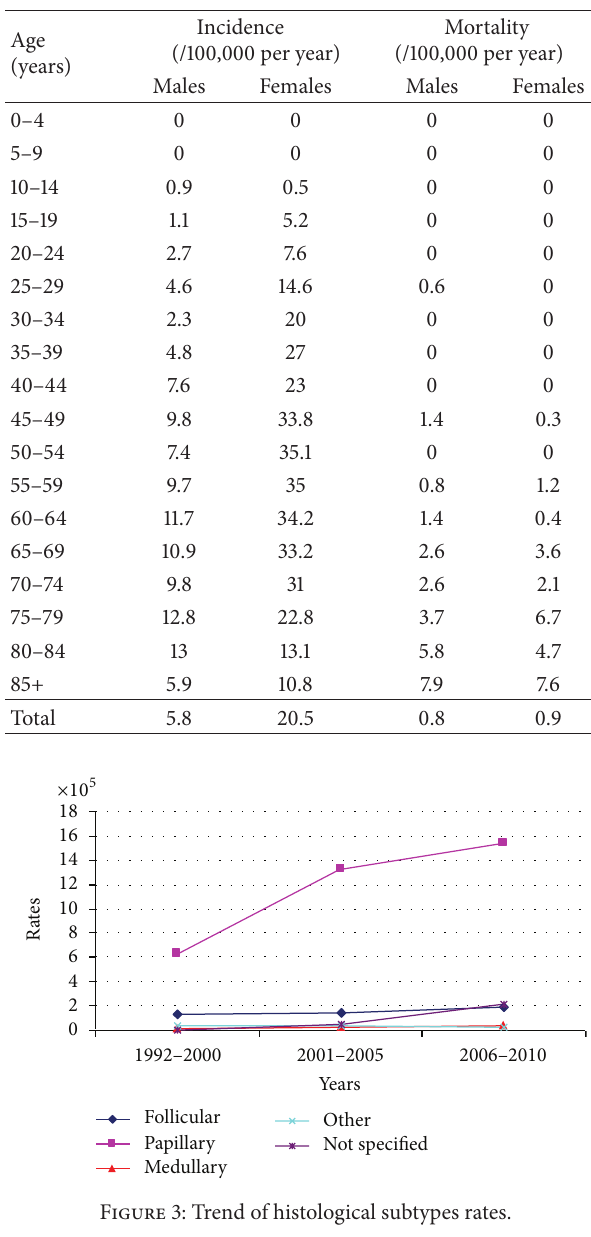
Table 2: Age-class incidence and mortality rates.